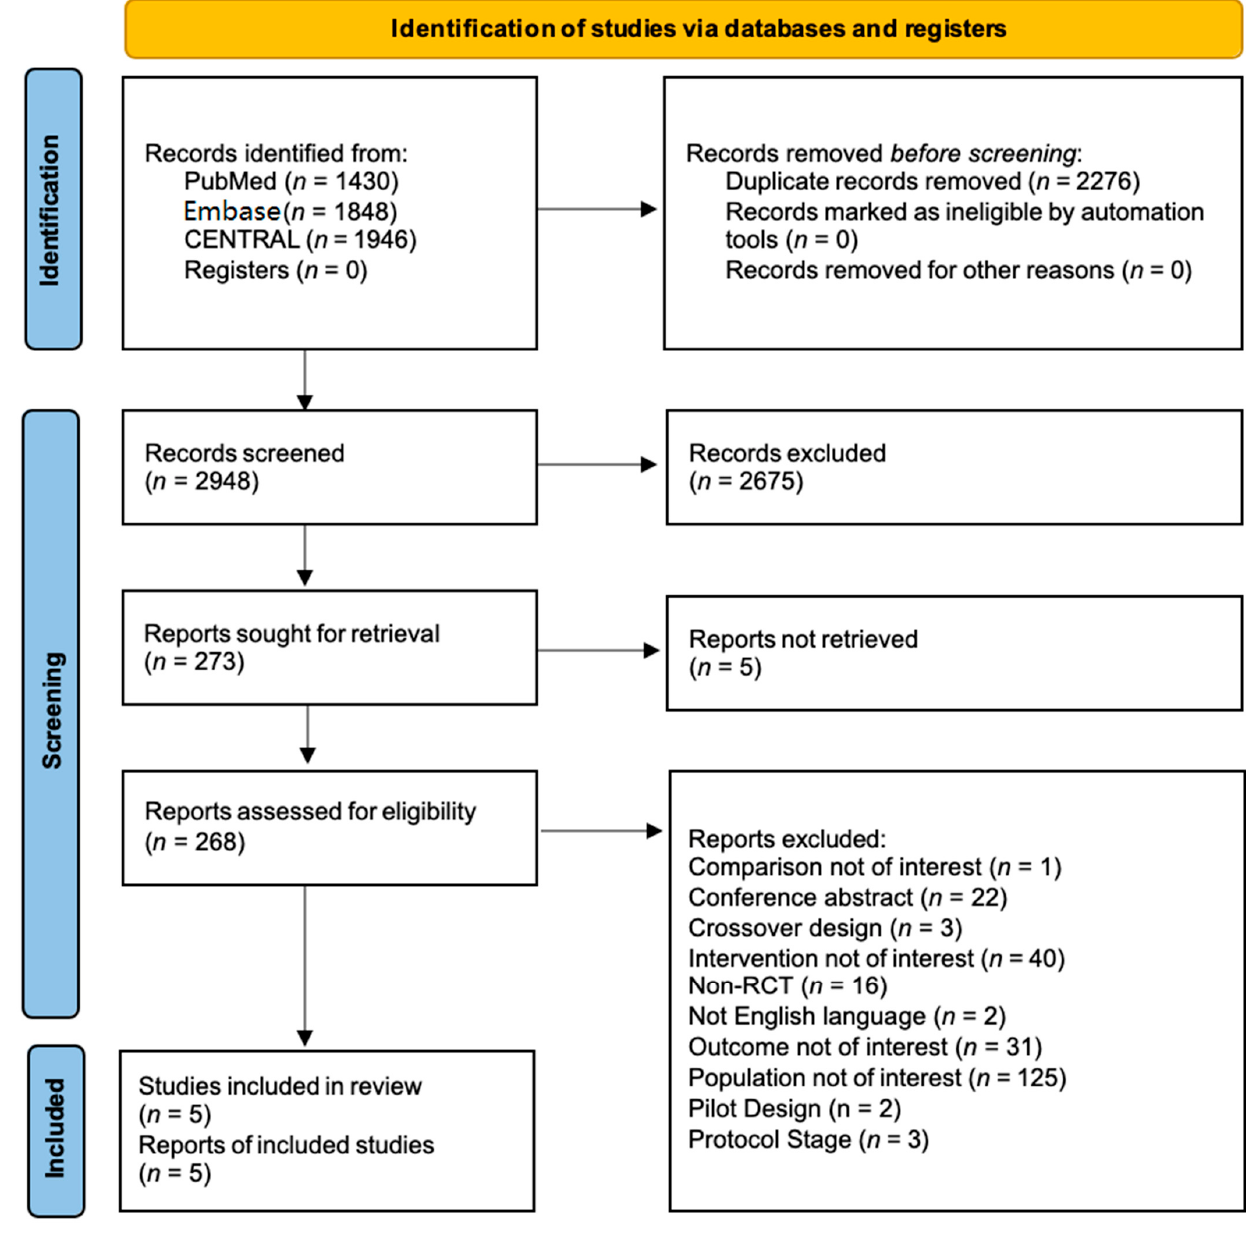
Figure 1. PRISMA-2020 flow diagram.